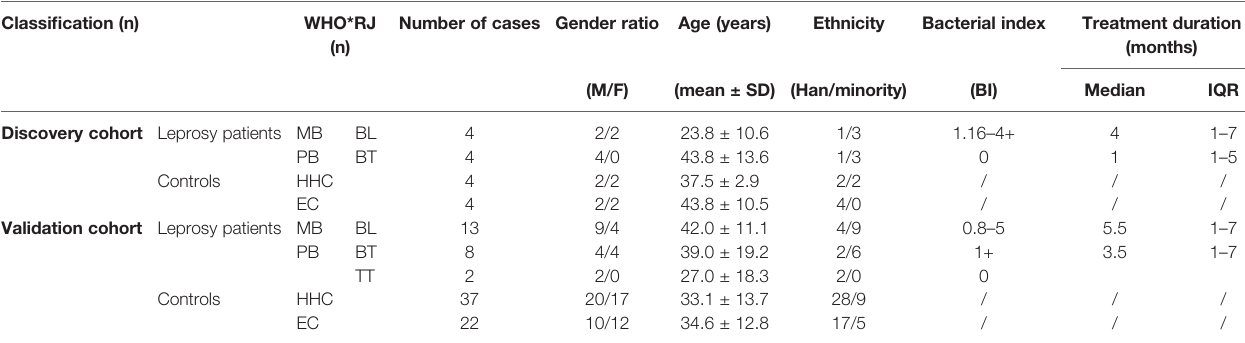
TABLE 1 | Clinical information of leprosy patients and